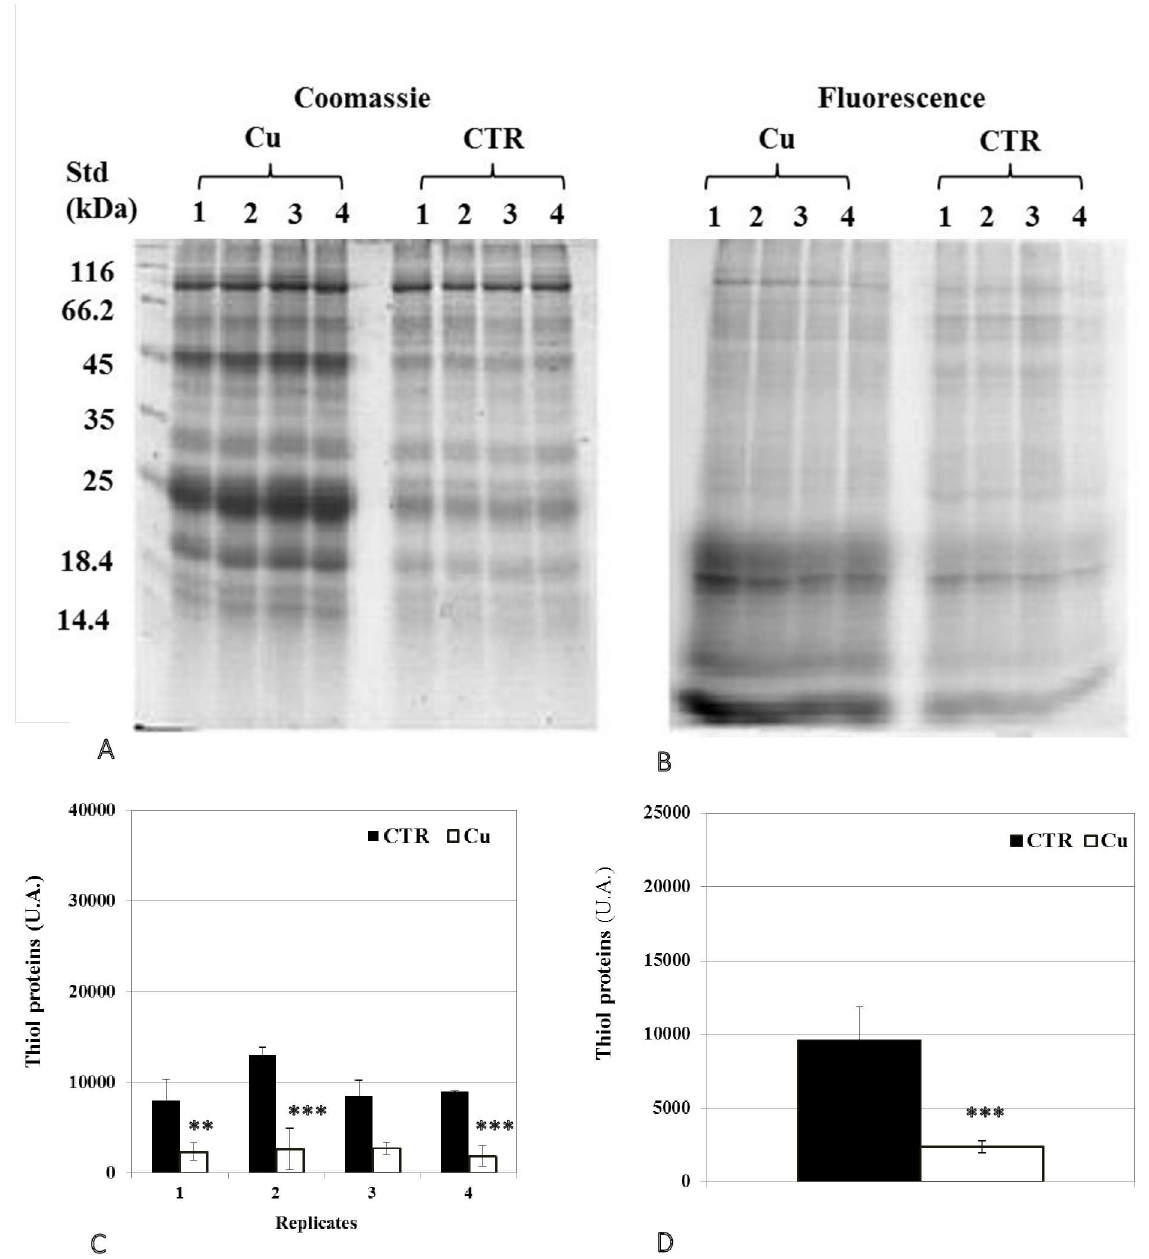
Fig 5. Representative images of 1DE gels of proteins (150 μ g) in cotyledons of bean seeds germinated for 9 days in the presenceof (A) distilled water (CTR) or (B) 200 μ M Cu. Gels were stained with Coomassie G-250 (scanned with GS-800 calibrated densitometer) and with IAF labeling (scanned with Typhoon 9400scanner). Total opticaldensities for each lane obtainedfrom IAF stainingwere normalized with those from Coomassie G-250 stainingof the same gel. (C, D) Levels of proteins containing thiol groups. Valuesshown are (C) means of 4 biologicalreplicates ( ± SD) numbered from 1 to 4, and (D) means of 4 technicalreplicates( ± SD).Each measurement was performed in an extract obtainedfrom severalcotyledons.Analyseswere performed using ANOVA, student’s T test; ** p < 0.01, *** p < 0.001.